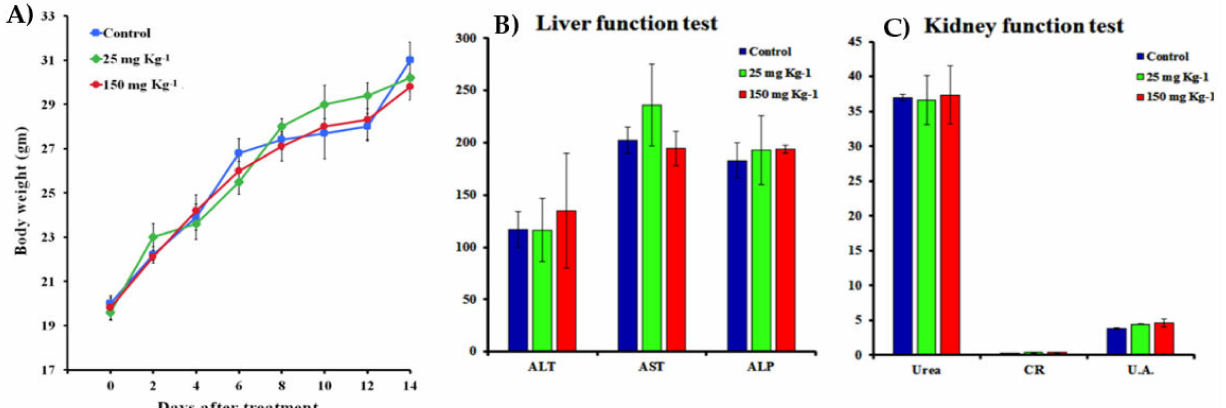
Figure 15. ( A ) Body weight changes for mice treated with TAM/RES–LbL-LCNPs at doses of 25 and 150 mg kg − 1 after 14 days. ( B , C ) Mice treated with TAM/RES–LbL-LCNPs were sacrificed, and blood was extracted and analyzed for biochemical parameters in the serum for liver and kidney functions. Non-treated animals were used, and non-significant changes were recorded. Data were analyzed by the differences between the doses and the control group. Alanine transaminase (ALT), aspartate transaminase (AST), alkaline phosphatase (ALP), creatinine (CR), and uric acid